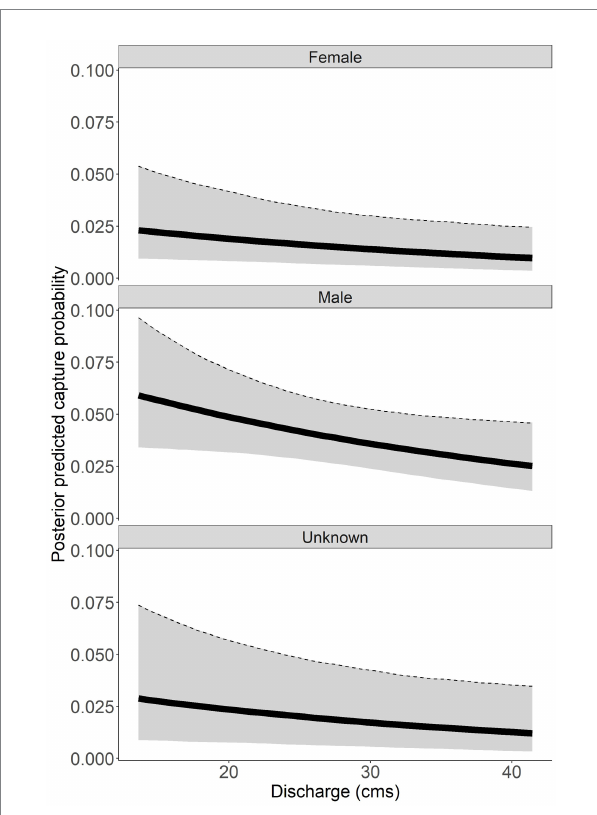
FIGURE 5 Posterior predicted capture probability of Sicklefin Redhorse Moxostoma sp. as a function of discharge (cubic meters per second, cms). Dark solid line represents the median and shaded area with dashed line represents the bounds of the 95% credible